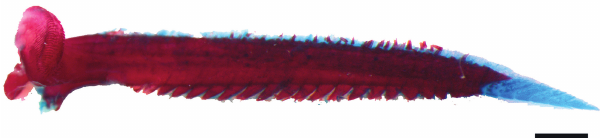
Fig. 5. Right pectoral spine of Scleromystax reisi , paratype, male, MNRJ 43857. Small, whiskerlike odontodes removed. Scale bar: 1.0